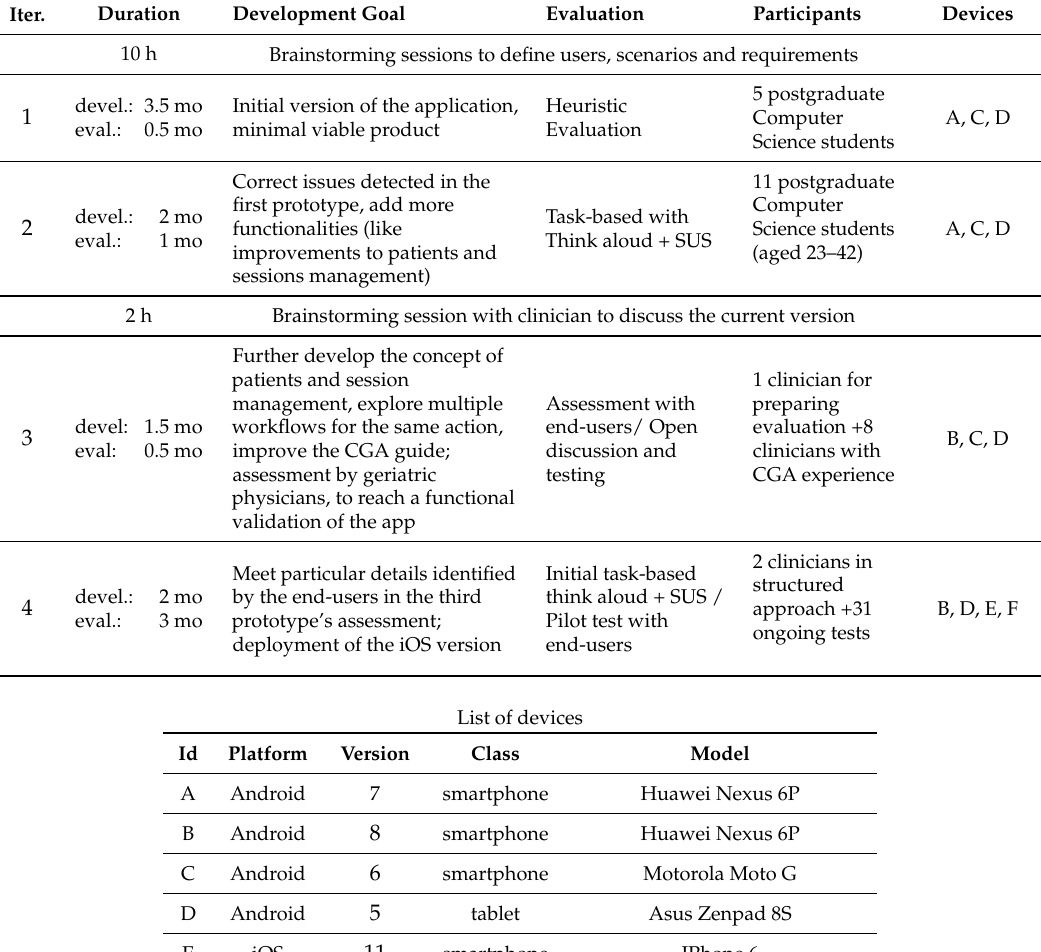
Table 4. The iterative user-centred design and development of Geriatric Helper comprised four prototypes. The evaluation method was adapted to the focus and development stage and the brainstorming sessions always included